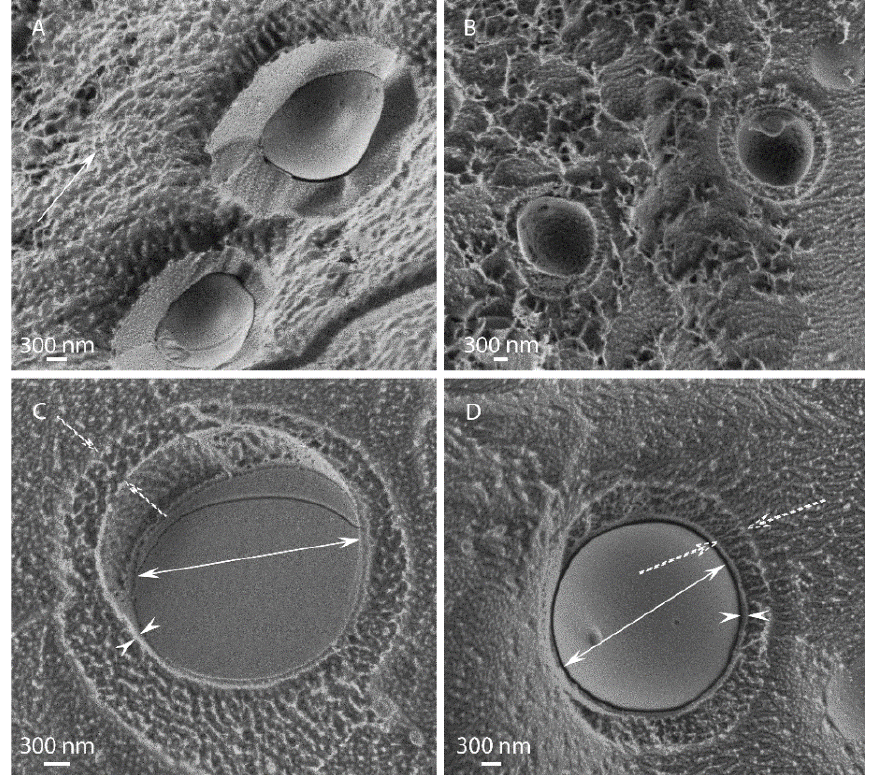
Figure 4. Cellulose capsules containing EU exhibiting egg-like structure at different magnifications fabricated by HPH under 5000 psi at cellulose:EO ratio 1:8. The single arrow (in ( A )) points to cellulose network in the background, the outer andinner pointing double arrows indicate the capsule inner diameter and inner shell thickness, respectively, and the dashed arrows point the outer shell thickness.